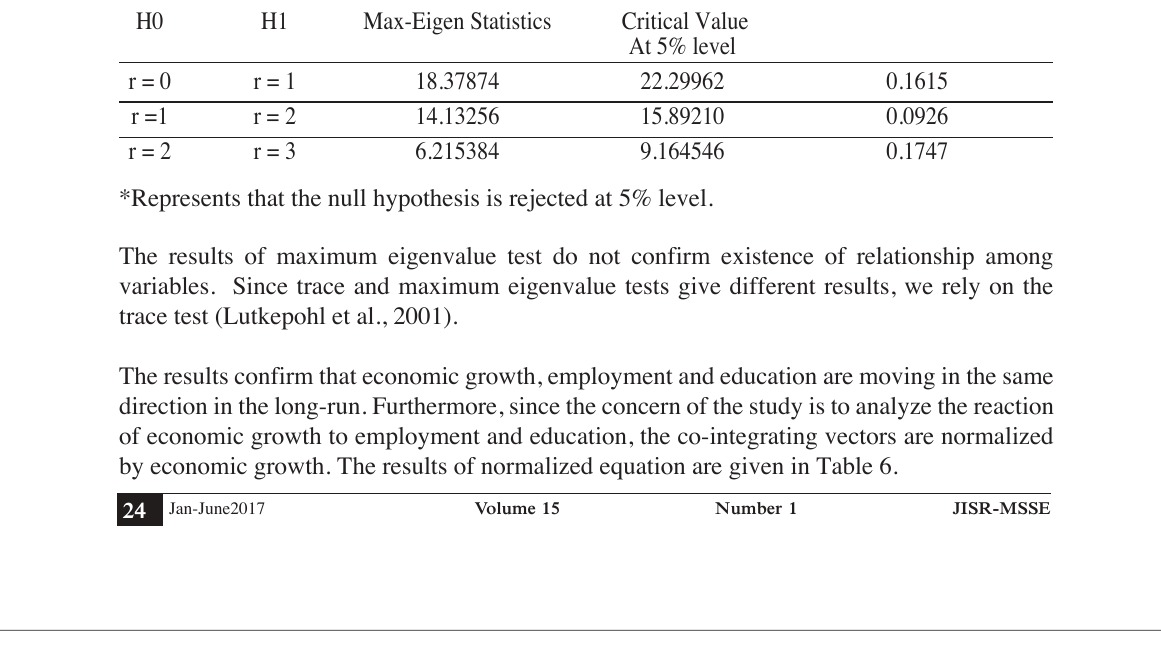
Table 5: Maximum Eigen value test results